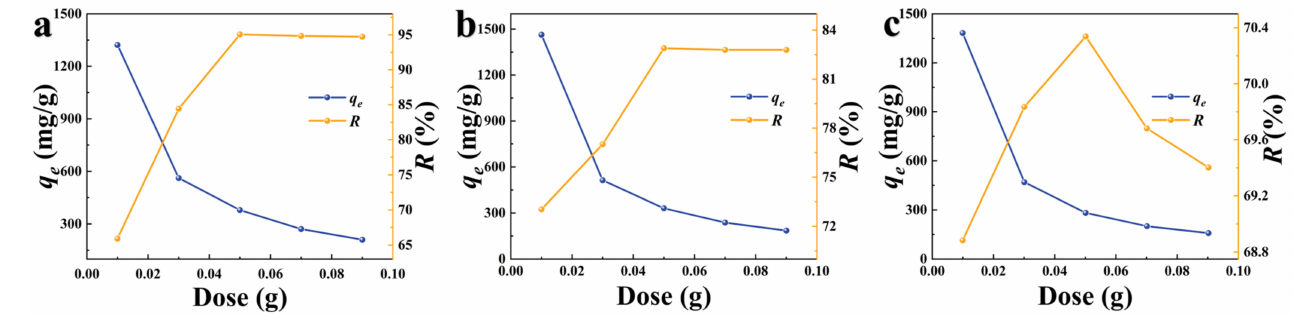
Figure 6. The effect of absorbent dosage on TC adsorption by modified crab shell biochar (( a ) is K − CSB; ( b ) is P − CSB; and ( c ) is M − CSB).